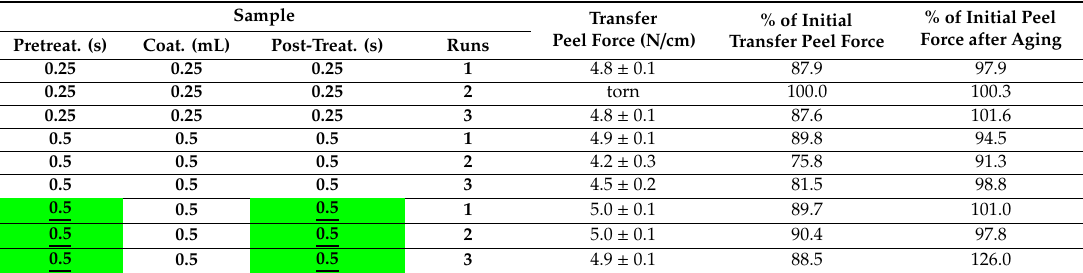
Figure 4. Graphs depicting peel force ( a ) and WCA values ( b ) measured on silicone-coated paper dependent on the number of treatment runs (treatment in nitrogen underlined and labeled green). Table 2. The transfer peel force and percentage values of initial peel force right after treatment and after the 3 months sample aging presented in Figure 4 (treatment in nitrogen underlined and labeled